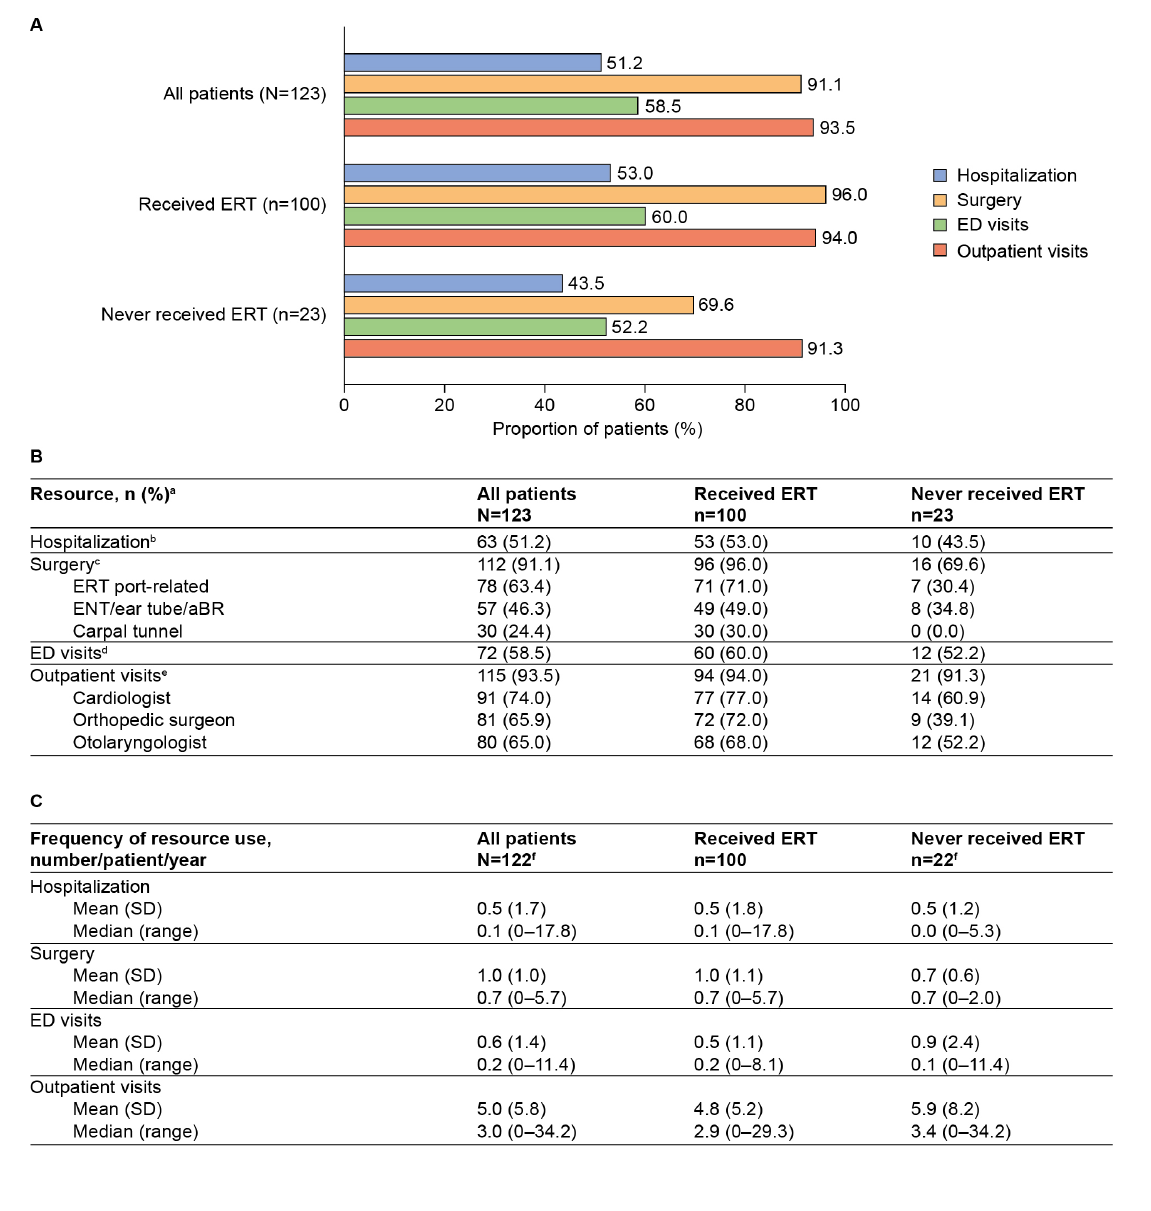
Figure 3. Summary of HRU (Resources Used at Least